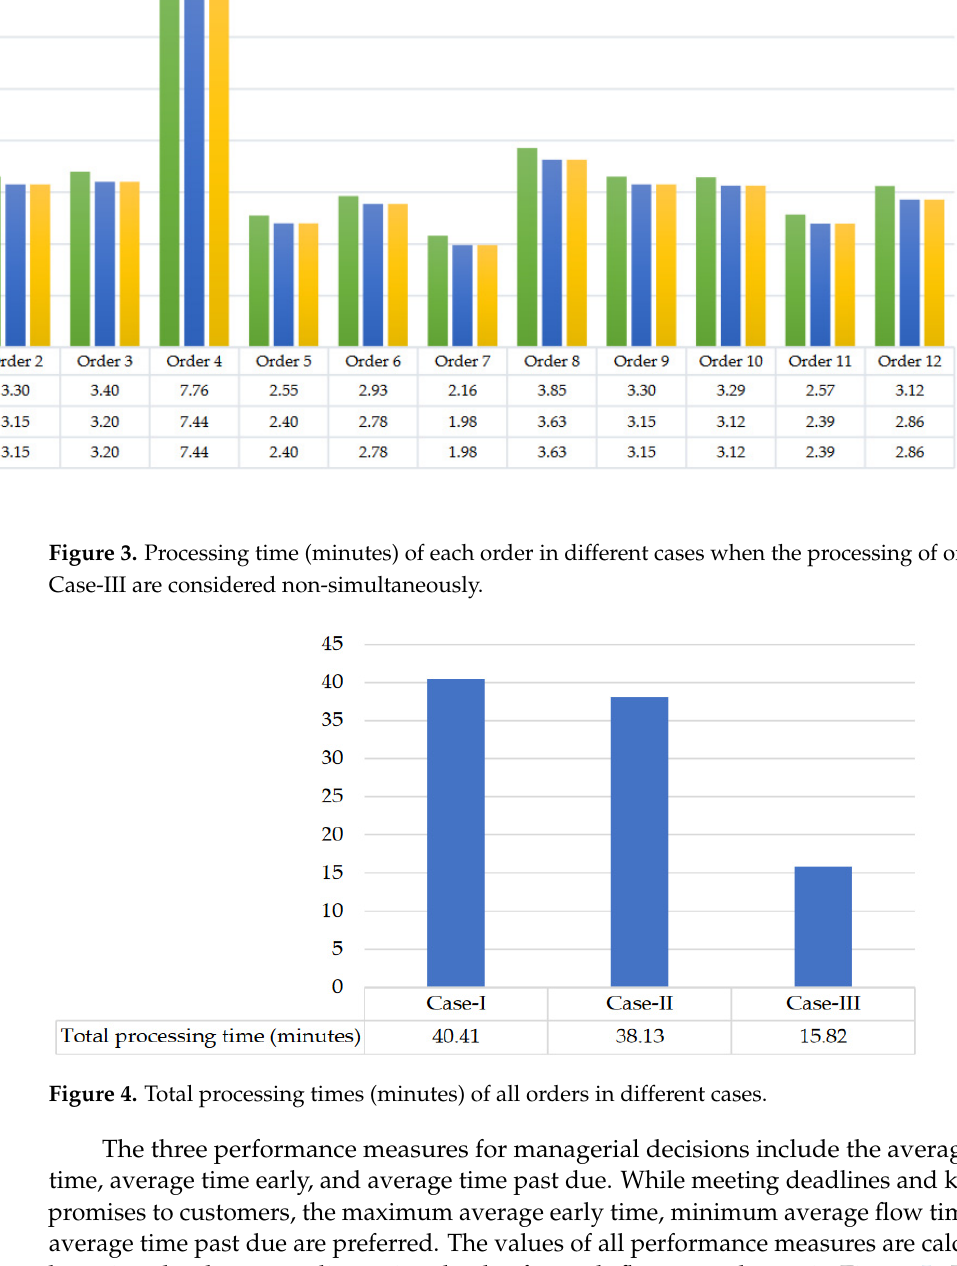
Figure 4. Total processing times (minutes) of all orders in different cases.